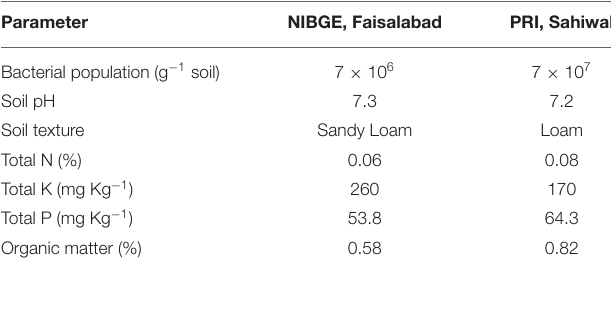
TABLE 4 | Bacterial population and physiochemical characteristics of soil from Faisalabad and Sahiwal fields. Parameter